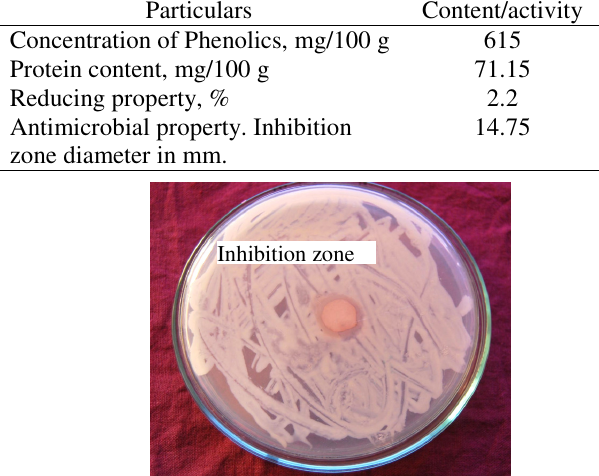
Figure 2 . Inhibition of staphylococcus by methanol extract of Ixora brachiata